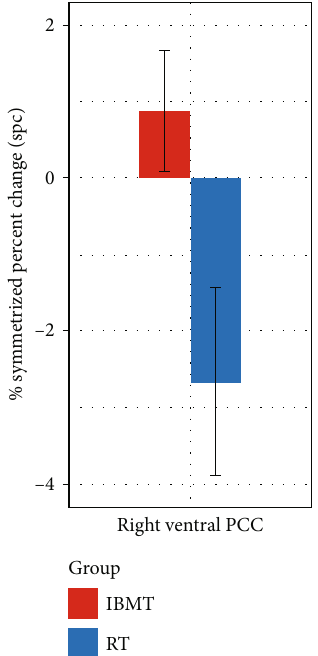
Figure 1: Symmetrized percent change (SPC) of right ventral PCC/ISC. Compared to RT, IBMT induced a signi fi cantly higher spc of right ventral PCC/ISC